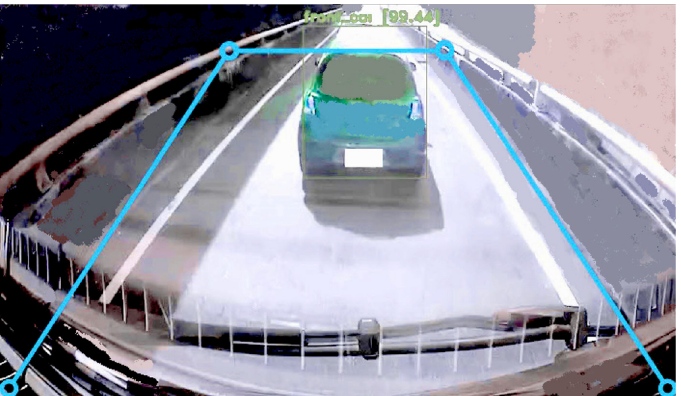
Figure 5. An example of the trapezoid area.